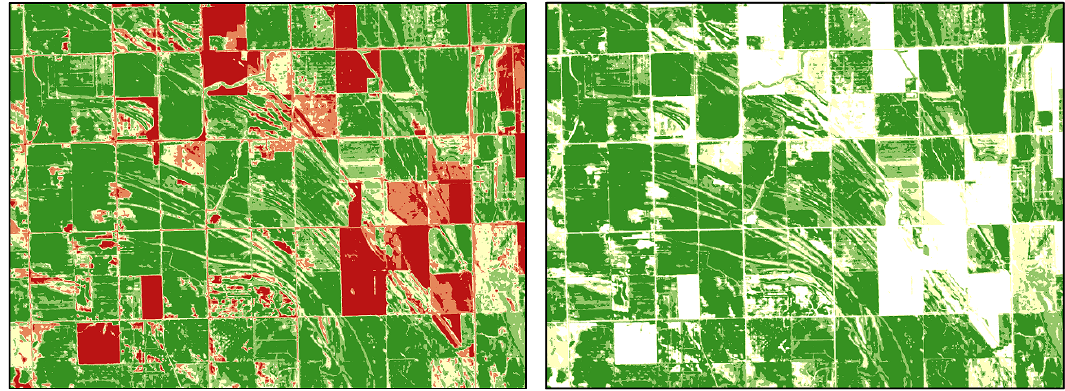
Figure 6. NDVI visualization after